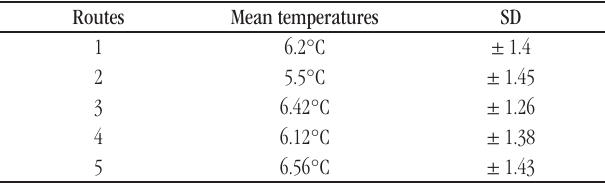
taBLE 2 − Biological materials transported under refrigeration * (2°C-8°C)